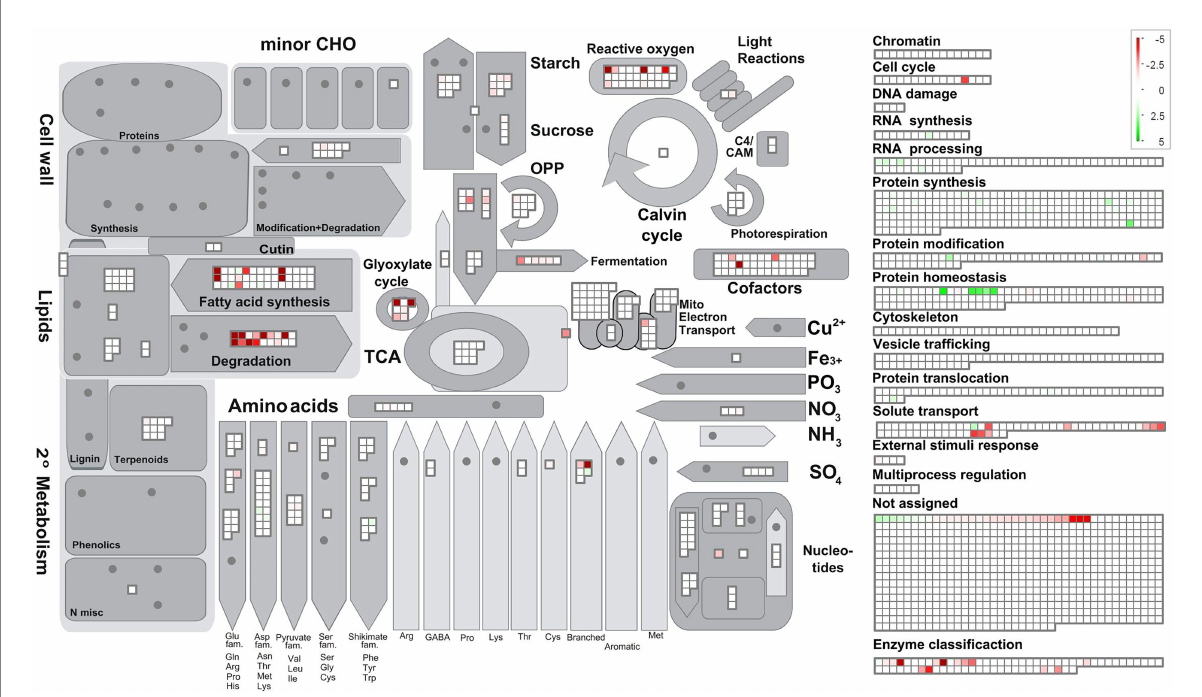
FIGURE 5 Schematic representation of cellular metabolism as a function of metabolic (sub) categories and log2 FoldChange values using the program MapMan, based on the results of Mercator. For all entries with a FC score a value of p <0.004 applies. Note that for increased visibility of the lower range of the log2 FC scale was set from 5 to − 5 whereas a few proteins on butyrate actually show higher FC